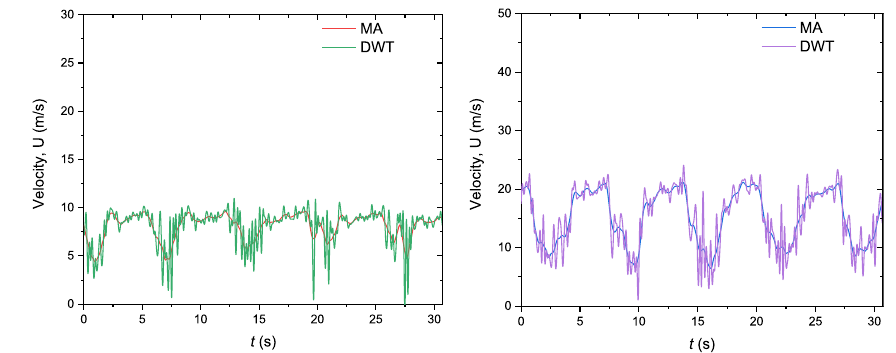
Fig. 9 Time history of the wind velocity of a single pseudo